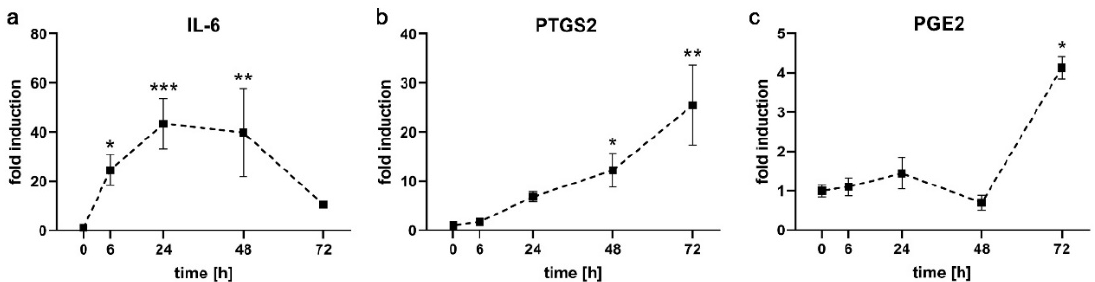
Figure2. Kineticsofpro-inflammatorymarkersinPDL-hTERTcellsundercompressiveload. Expression Figure 2. Kinetics of pro ‐ inflammatory markers in PDL ‐ hTERT cells under compressive load. of pro-inflammatory genes IL-6 ( a ) and PTGS2 ( b ) at the specified time points was determined via Expression of pro ‐ inflammatory genes IL ‐ 6 ( a ) and PTGS2 ( b ) at the specified time points was qRT-PCR, amounts of PGE2 in cell culture medium were measured by ELISA ( c ). Values were referenced determined via qRT ‐ PCR, amounts of PGE2 in cell culture medium were measured by ELISA ( c ). to arithmetic means at T = 0 h and are shown as fold over non-treated controls at the respective time Values were referenced to arithmetic means at T = 0 h and are shown as fold over non ‐ treated controls points ± SEM. n = 2, n = 6, * 0.01 ≤ p < 0.05, ** 0.001 ≤ p < 0.01, *** 0.0001 ≤ p < at the respective time points ±SEM. n = 2, n = 6, * 0.01 ≤ p < 0.05, ** 0.001 ≤ p < 0.01, *** 0.0001 ≤ p < 0.01.